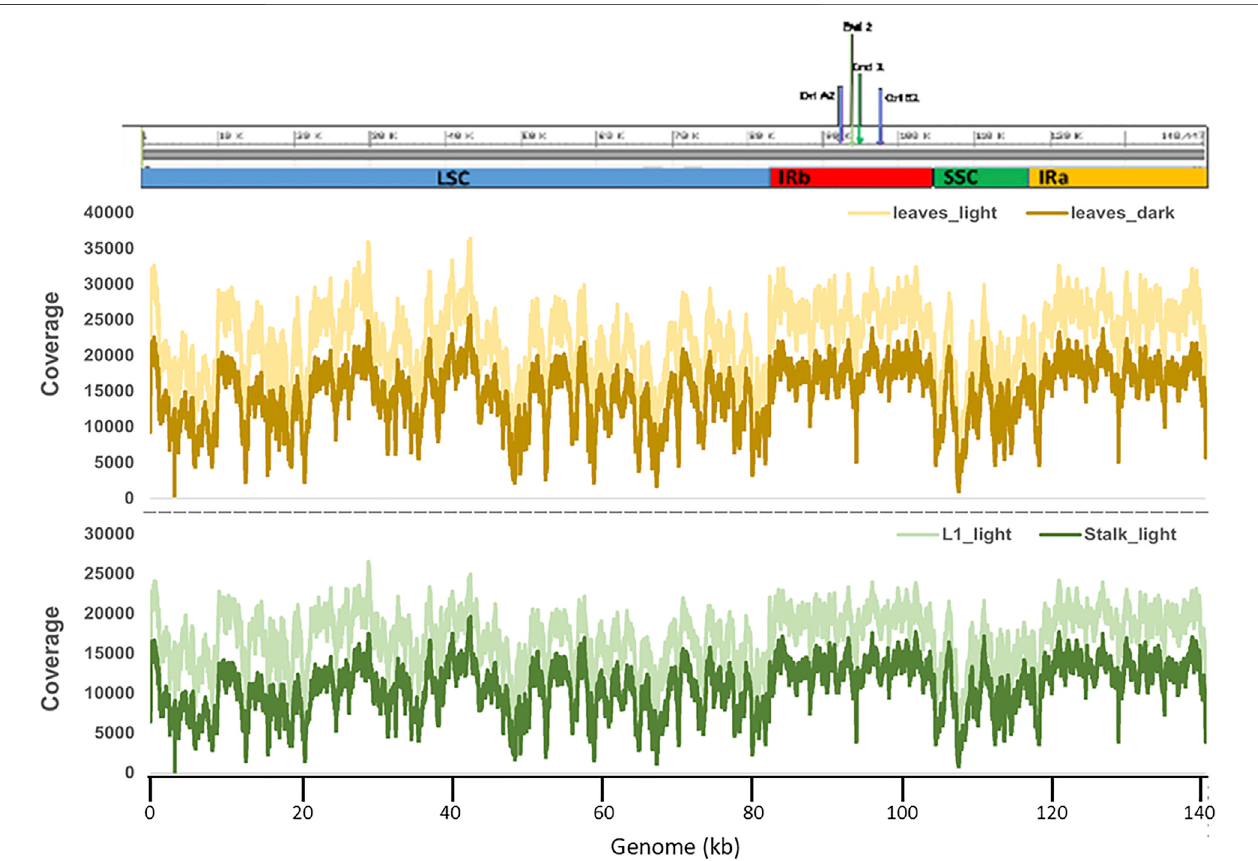
FIGURE 1 | Read depth of coverage for Illumina sequencing of plastid DNA from four maize tissues. Graphs show the read depth (coverage) trend of all four samples along the entire length of the plastid genome. The upper panel shows a schematic representation of the Z. mays B73 plastid reference genome (NCBI # KF241981.1)withthefourmainregionsindicated:LSCinblue;IRbinred;SSCingreen;andIRainyellow.Themiddlepanelshowsthecomparisonofreaddepthsofthe Leaves_light and Leaves_dark ptDNA samples. The bottom panel shows the comparison of read depths of L1_light and Stalk_light samples. The bottom x -axis gives the nucleotide (nt) numbering following the convention of nt1 at the beginning of the LSC.